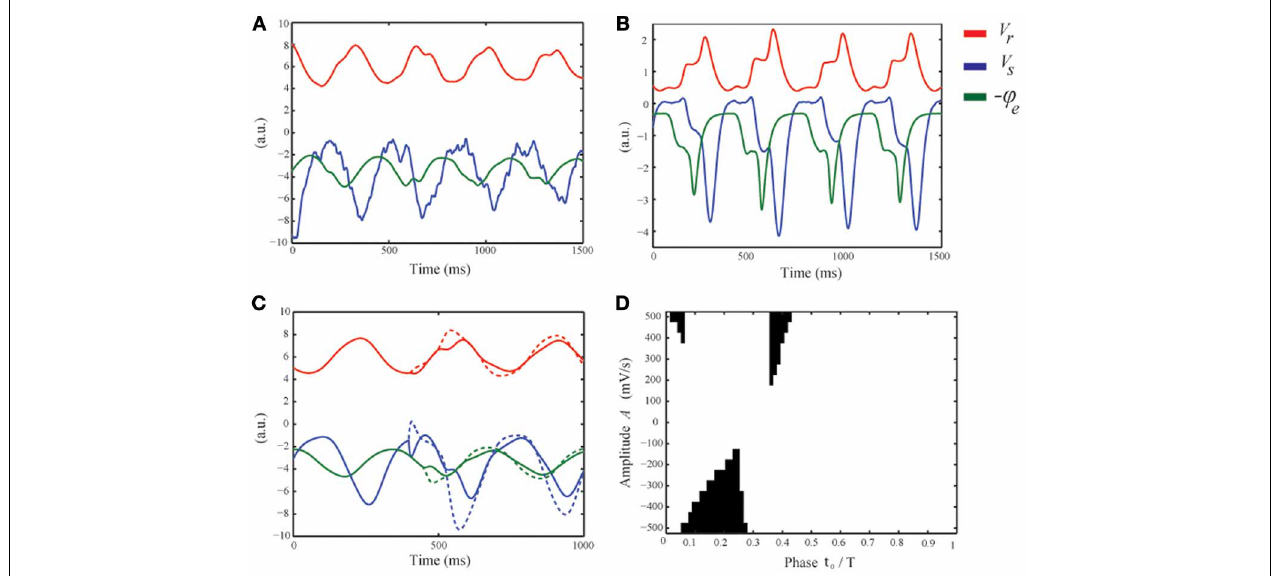
ν se = 2 . 2mV s and in the absence of noise, a perturbation with amplitude A = − 500 (solid) and A = − 500 (dashed) is applied. The negative perturbation leads to a spike, while the positive perturbation merely advances the delta cycle. (D) The black regions correspond to the values of t 0 and A for which the applied perturbation leads to a spike.